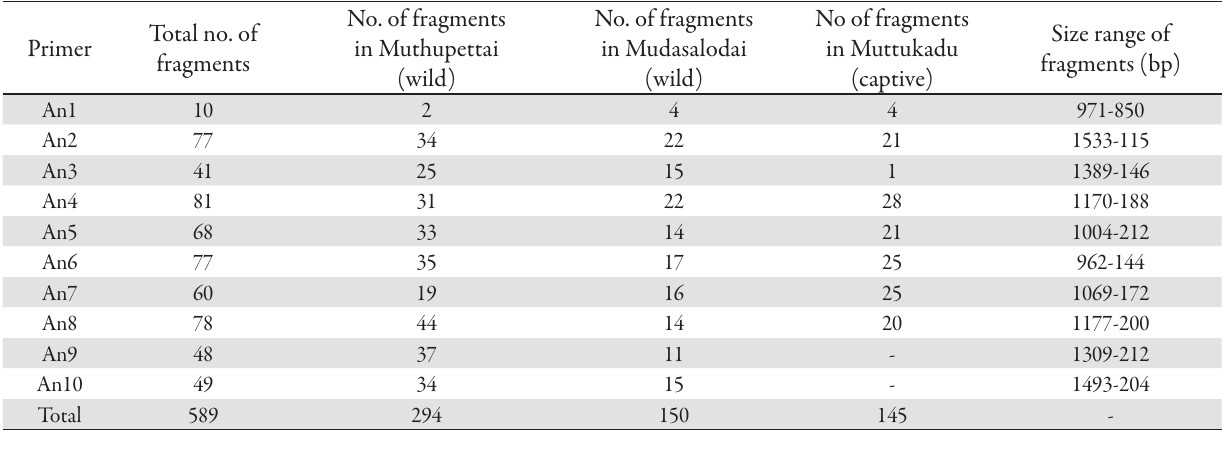
Tab. 3. Genetic identity (above diagonal) and genetic distance